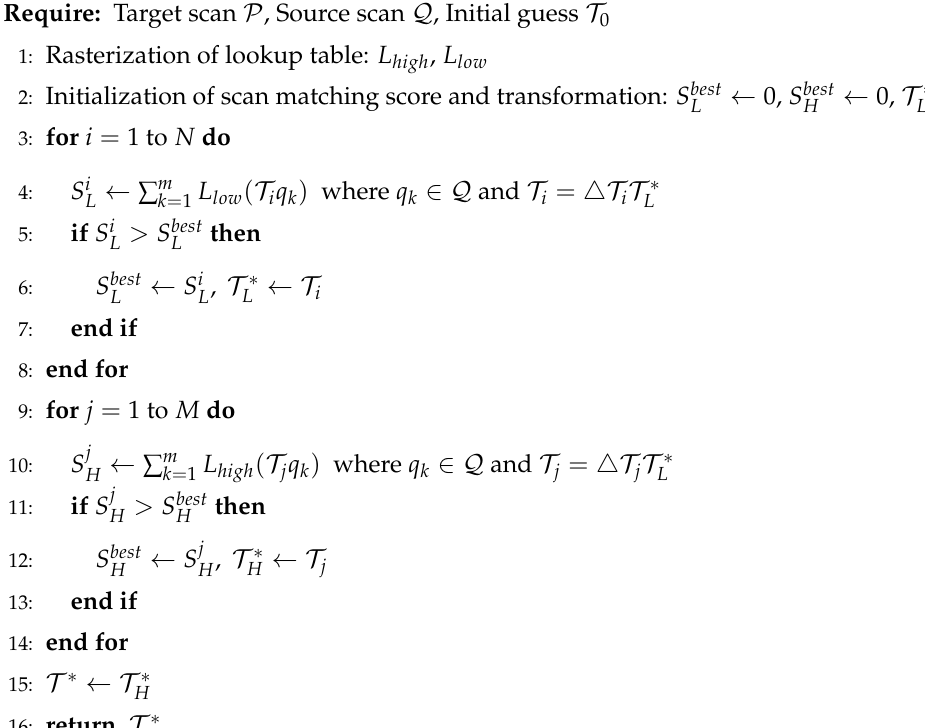
Algorithm 1 The multi-resolution CSM